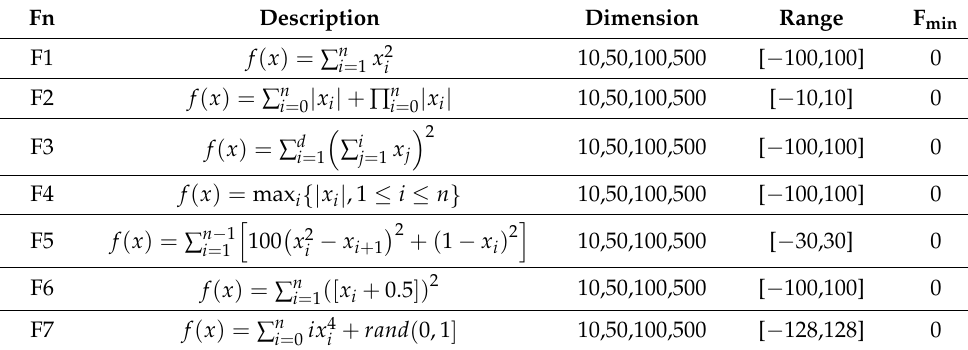
Figure 1. Flowchart of modified Aquila optimizer. Table 2. Unimodal benchmark